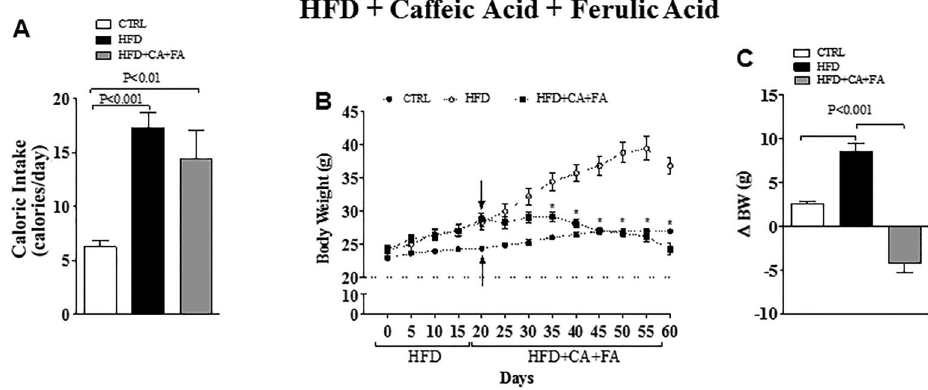
Figure 2. Effect of a high-fat diet (HFD) with combined treatment of caffeic acid (CA) and ferulic acid (FA) (0.9 and 50 mg (cid:3) kg – 1 (cid:3) day – 1 , respectively) on diet-induced obesity. A , Caloric intake calculated from daily food consumption. B , Body weight (g). Arrows indicate when the treatment with CA and FA was initiated. C , Body weight gain ( D BW) after 40 days of treatment with CA and FA. Data are reported as means ± SEM of fi ve animals per group. *P o 0.01 control (CTRL) vs HFD (ANOVA followed by the Student Newman-Keuls